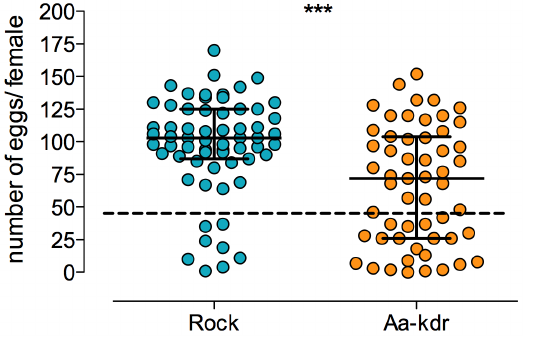
Figure 5. Number of eggs laid by females from Rock and Rock- kdr Ae.aegypti strains. Each dot represents a single female. Only females that laid at least one egg were included. Median value with interquartile range is shown for each distribution. Dotted line points 50 eggs/female, which was herein empirically considered as discriminative of successful insemination. ***Difference between strains was highly significant by t test.